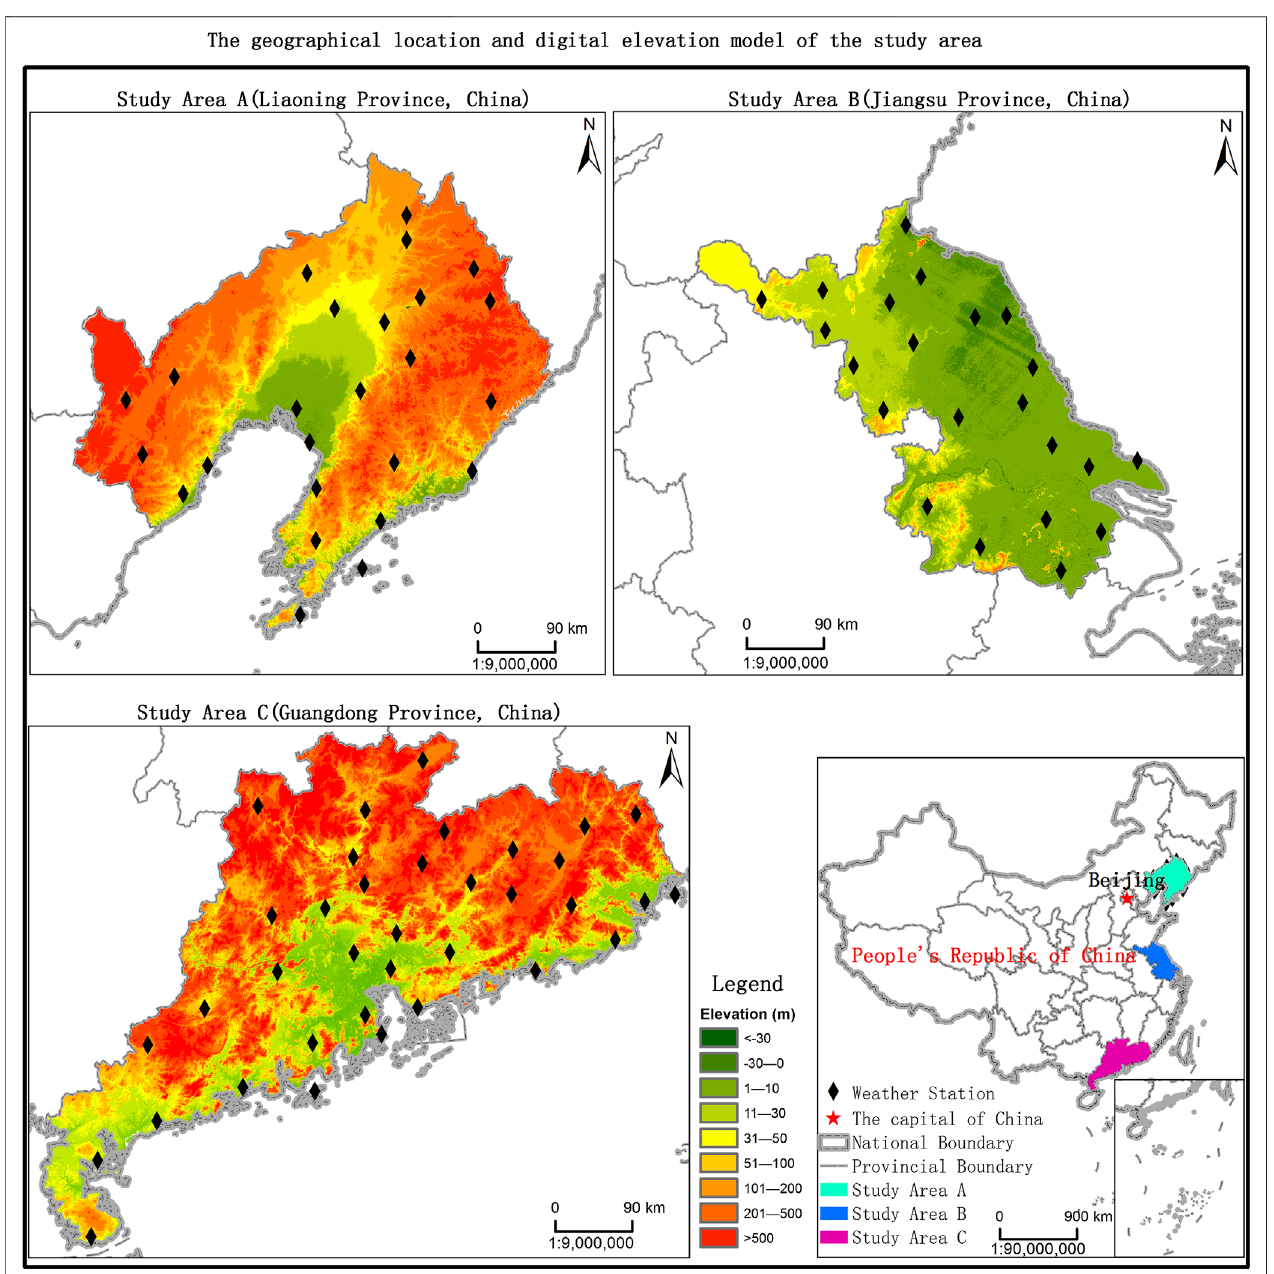
FIGURE 1 | Schematic diagram of (A) Liaoning, (B) Jiangsu, and (C) Guangdong research areas.